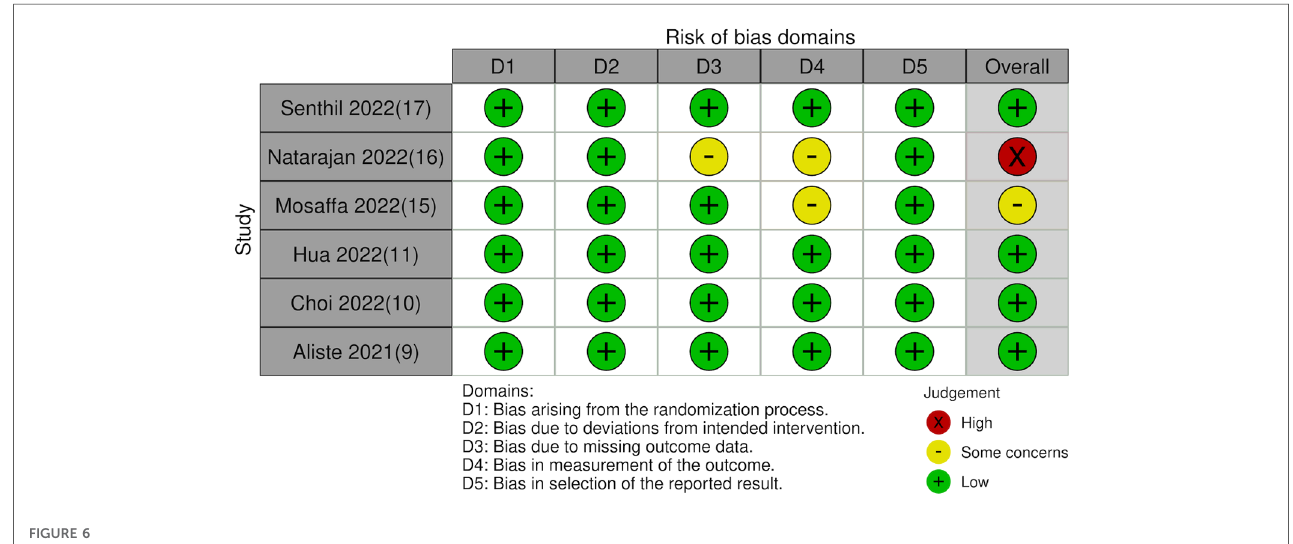
FIGURE 6 Risk of bias